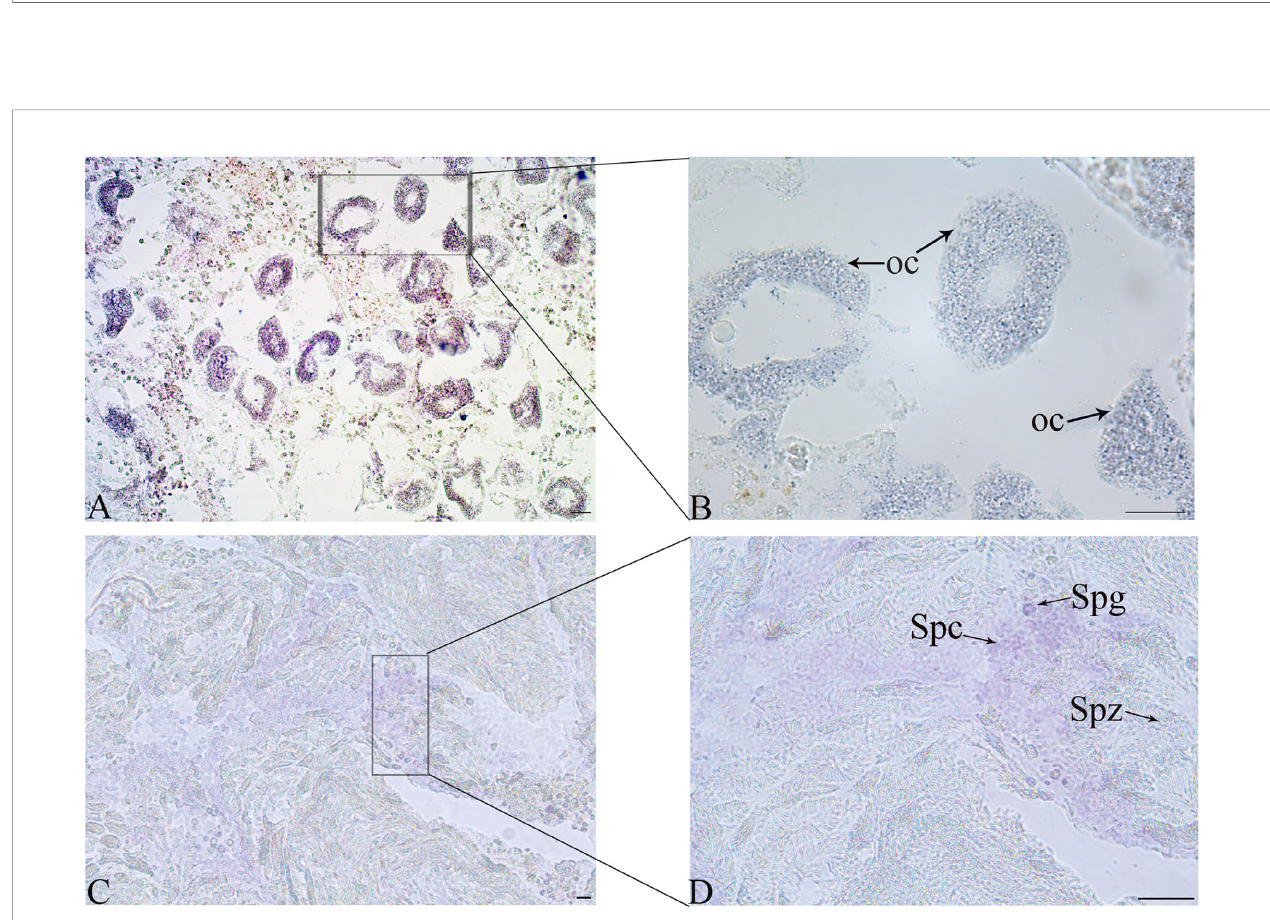
FIGURE 4 | Cellular location of Tc-Piwi1 in female and male gonad tissues demonstrated by in situ hybridization (ISH). (A, B) The results of ISH with Tc-Piwi1 mRNA antisense probe in the ovary (Scale bar = 40 µm). (C, D) represent the results of ISH in testis by Tc-Piwi1 mRNA antisense probe (Scale bar = 25 m m). The positive signals were stained with dark-blue or purple. The cells in histological sections include spermatozoa (Spz), spermatocyte (Spc), spermatogonia (Spg), and oocyte (Oc).